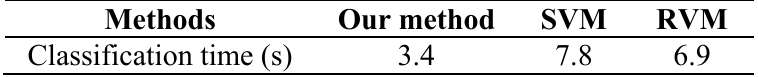
Table 2. Classification time for different methods on tumor detection.